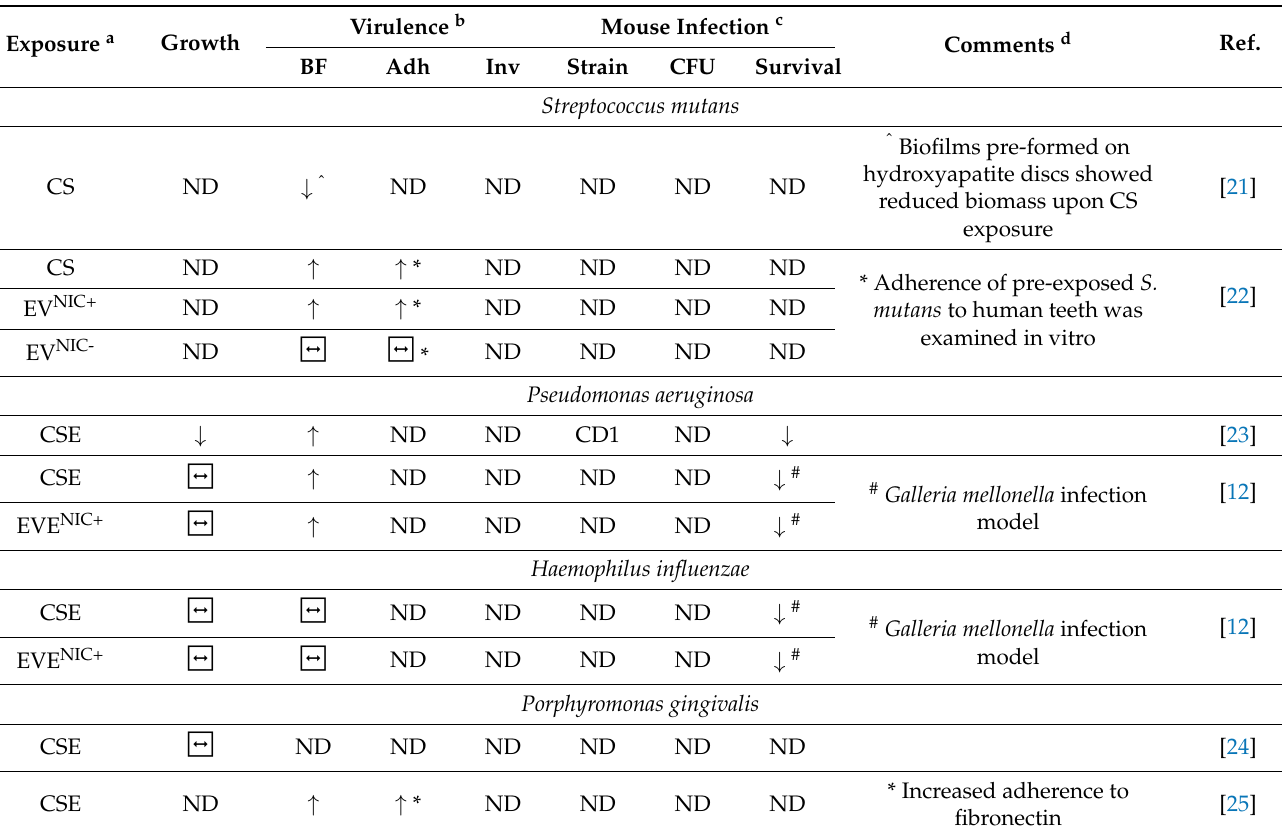
Table 1. Effects of CS/EV exposure on pathogen virulence examined in vitro and in vivo.